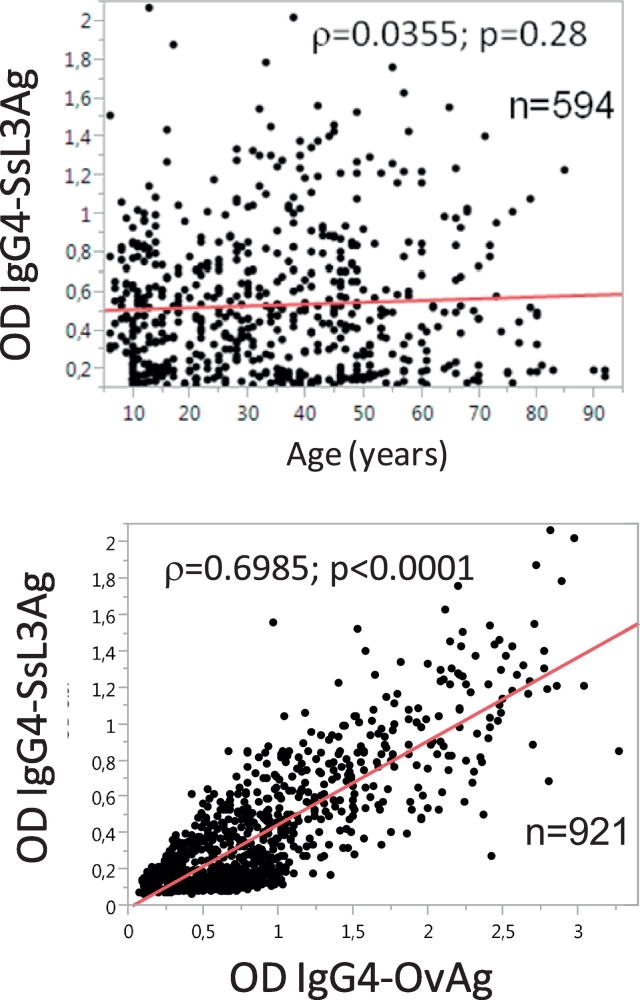
The IgG4 responses to S. stercoralis L3 antigen (SsL3Ag) in correlation with the age (in years) of the study participants (upper graph), and the correlation of the SsL3Ag-specific IgG4 and the OvAg-specific IgG4 reactivity (lower graph) (OD = optical densities).